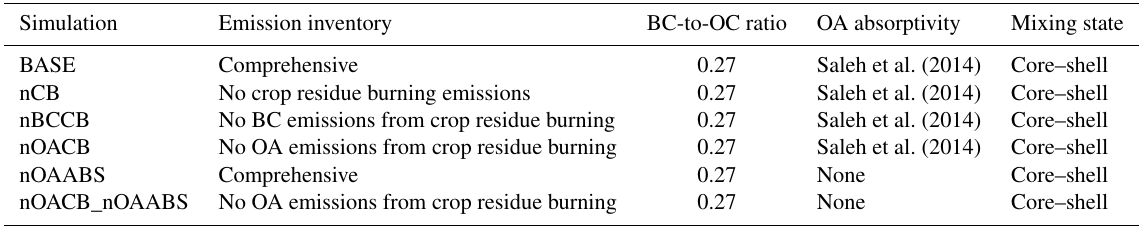
Table 2. Descriptions of the main simulations.